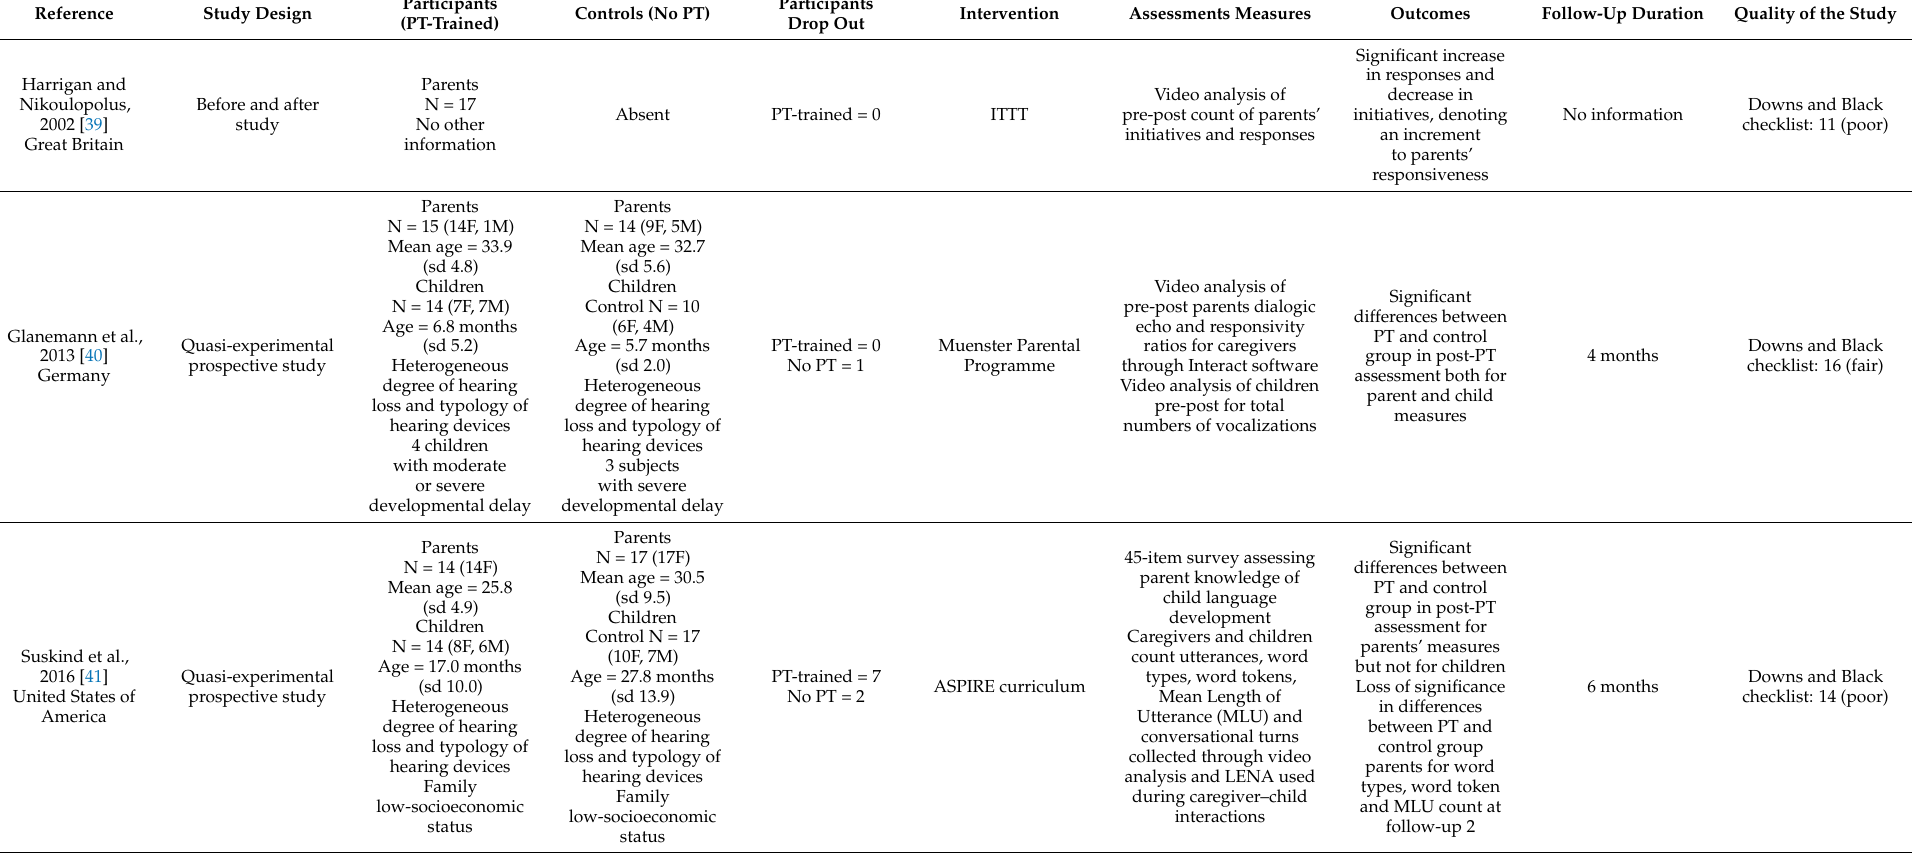
Table 1. Summary table of articles included in the